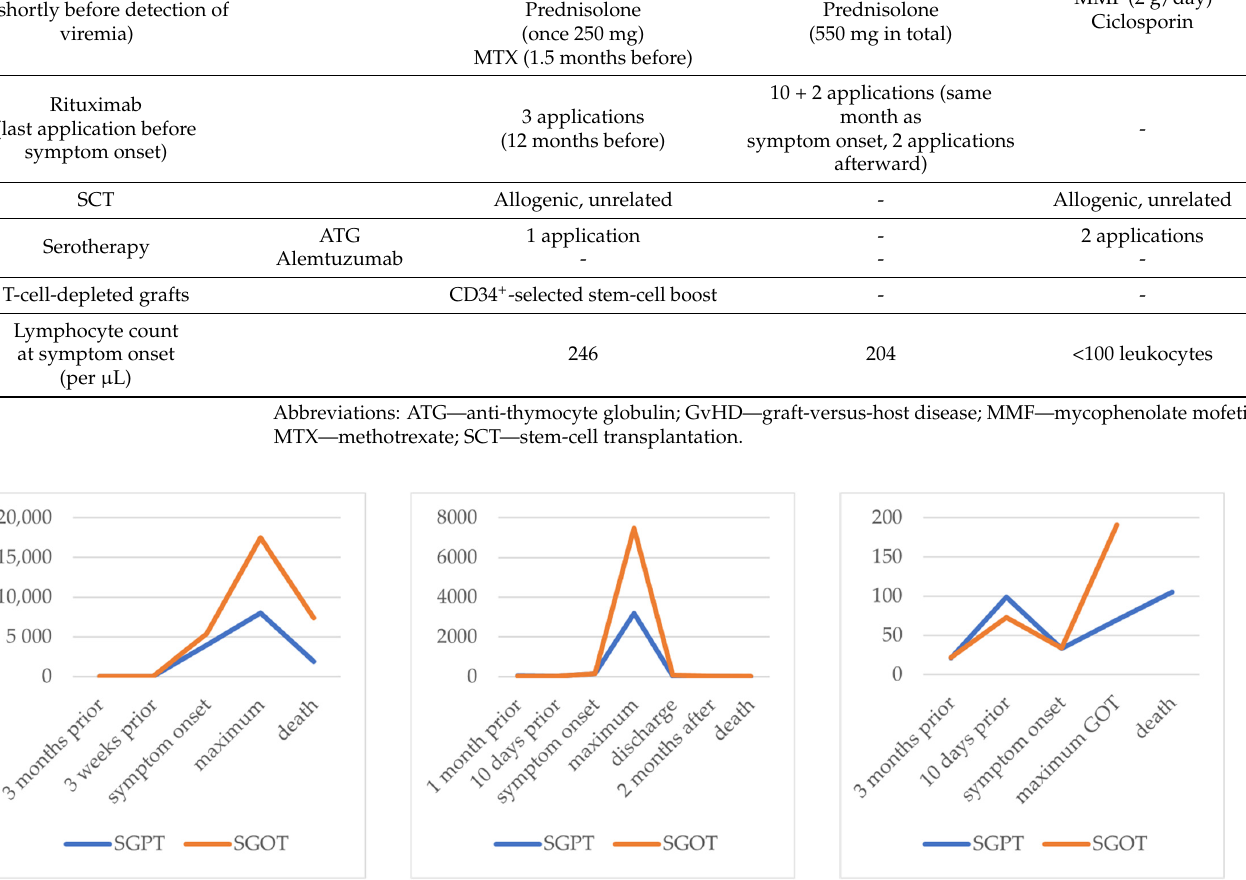
Table 2. Patients’ risk factors.